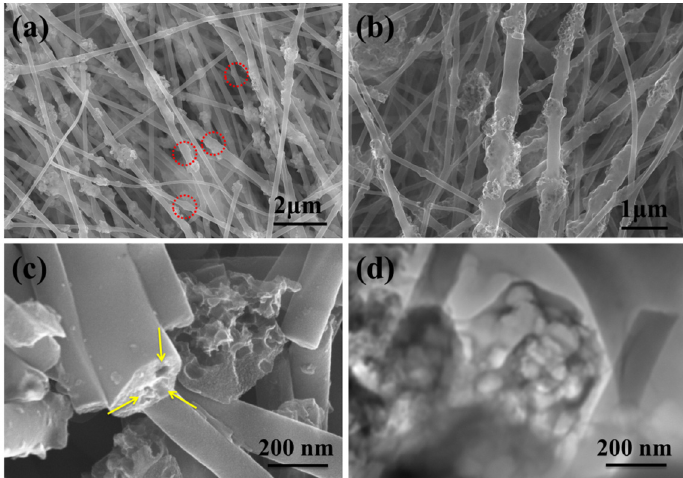
Figure 3. Morphology characterization: ( a , b ) SEM images of electrospun PAN-CaCO 3 hybrid NFs by treating with carbonization and HCl; ( c ) SEM image for the cross-section of porous CNFs; ( d ) TEM image of the porous CNFs.